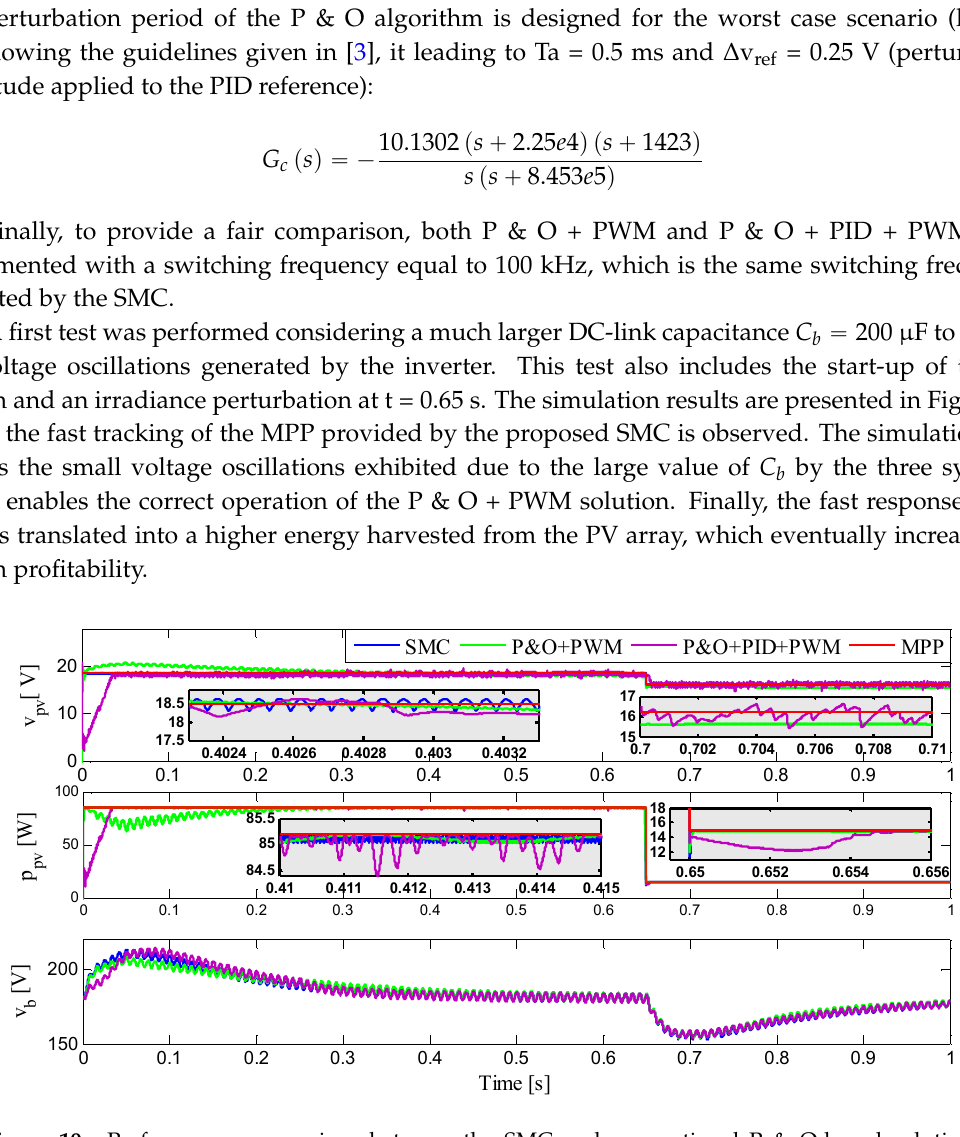
Figure 19. Performance comparison between the SMC and conventional P & O-based solutions considering small DC-link voltage oscillations.